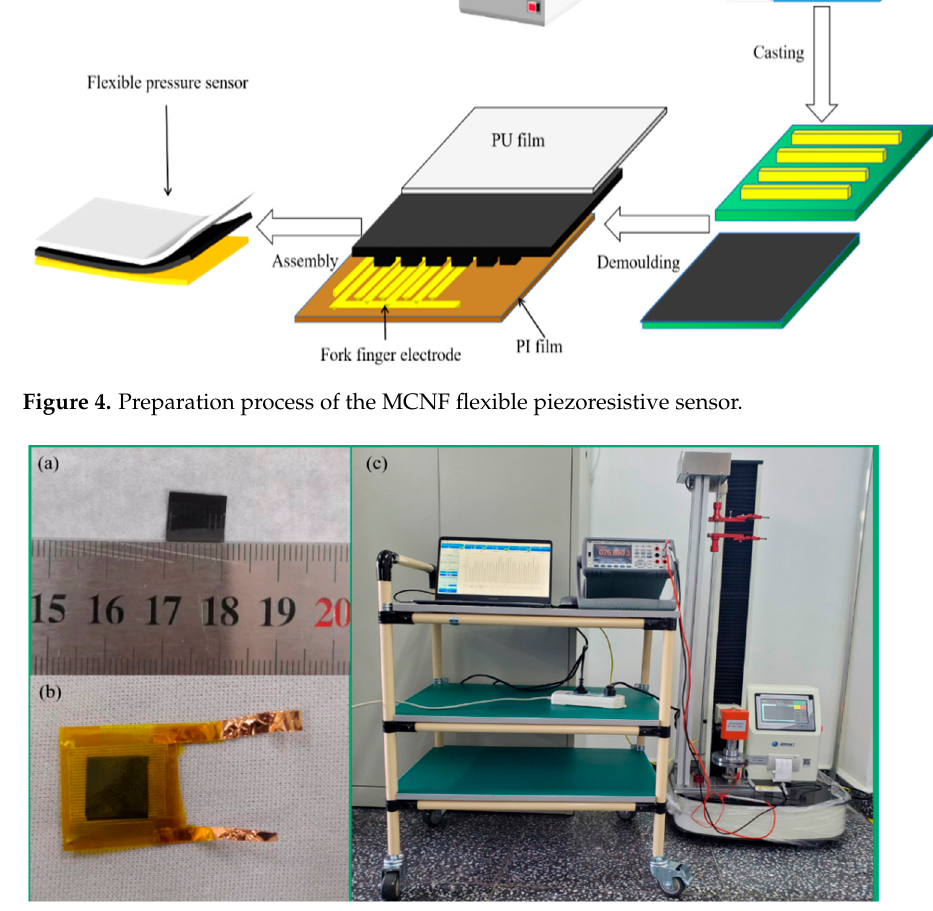
Figure 5. Pictures of the flexible sensor and experimental setup. ( a ) Size of the MCNF. ( b ) Optical image of a fabricated pressure sensor. ( c ) Measurement system for the flexible pressure sensor.